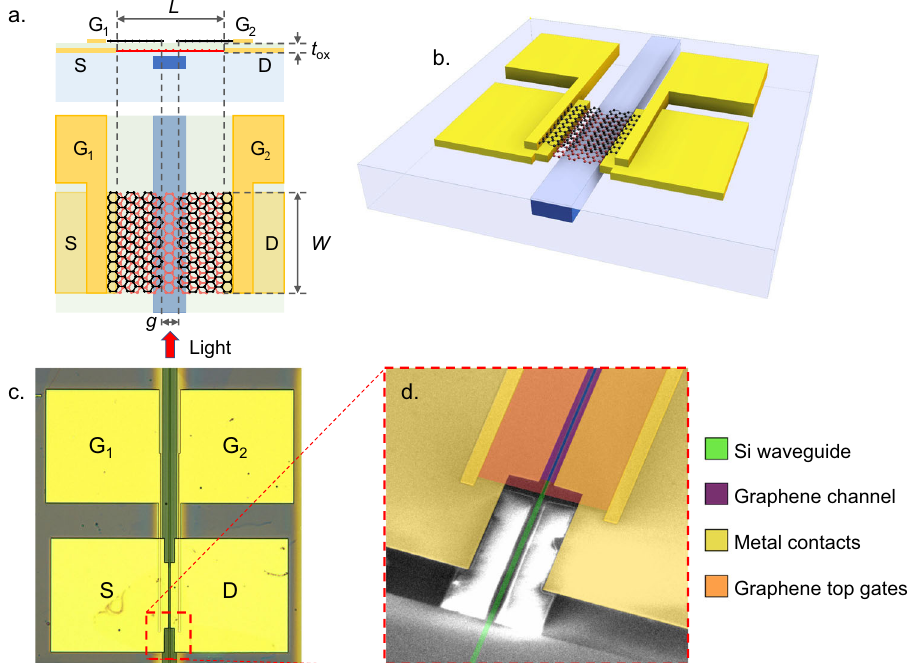
Fig. 1 Structure of the realized device. a Cross section and top view of the designed PTE graphene photodetector. The active region is the fi rst layer of graphene: the channel (red) of length L and width W , on top of the 480 nm × 220 nm Si waveguide (blue, light blue is SiO 2 ). The channel is accessed electrically by the source (S) and drain (D) metal contacts (yellow). A 100 nm thin SiN layer (light green) is used as dielectric spacer for the gates. Top gates are realized with a second layer of graphene (black) patterned in a split gate con fi guration with a gap (g) of 150 nm. Graphene gates are contacted through metal contacts (G 1 and G 2 ). b 3D schematic of the proposed PTE graphene photodetector. c Optical microscope picture of the fabricated devices: scale bar is 20 µ m. d False color SEM image of the input of the fabricated PTE graphene photodetector: green the Si waveguide, yellow the metal contacts, purple the active graphene channel (violet on the Si waveguide), orange the second graphene gates. Scale bar is 5 µ